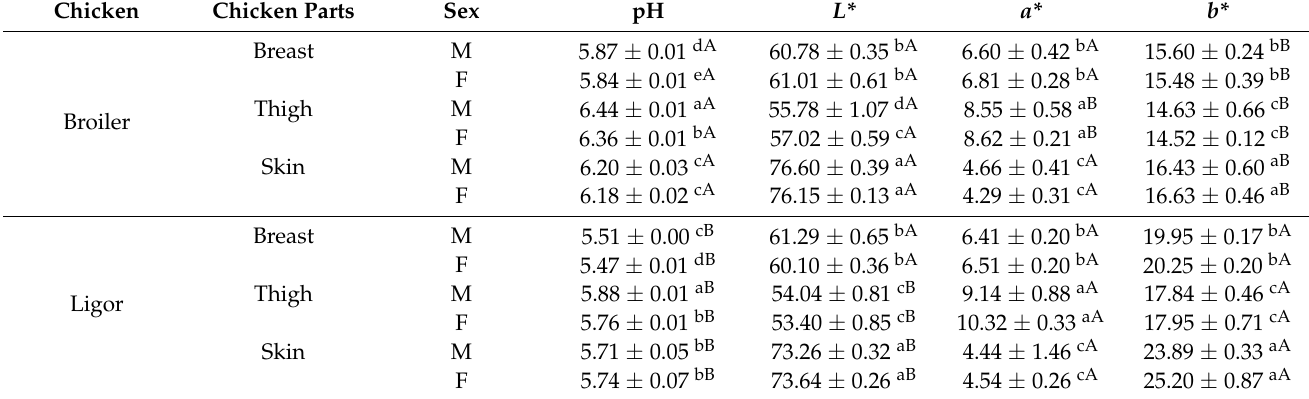
Table 2. Physicochemical properties of breast, thigh, and skin of broiler and Ligor hybrid chicken from different